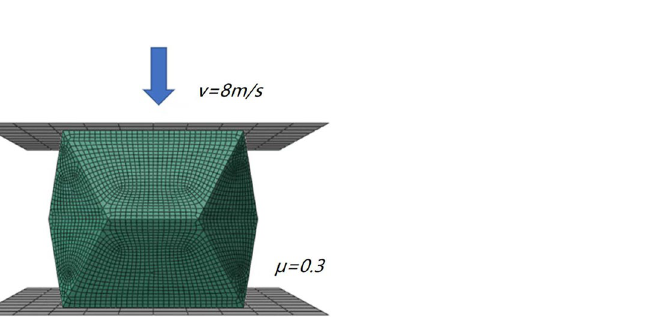
Figure 6. Numerical simulation